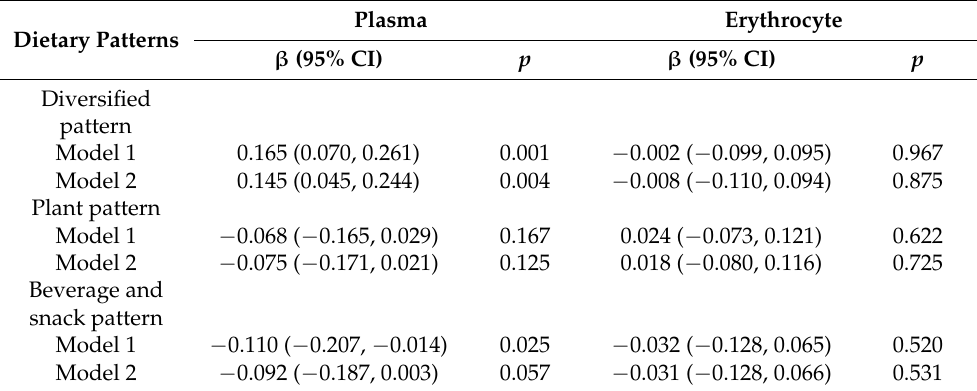
Table 3. The association of dietary patterns with plasma and erythtocyte DHA status by multivariate linear regression analysis.